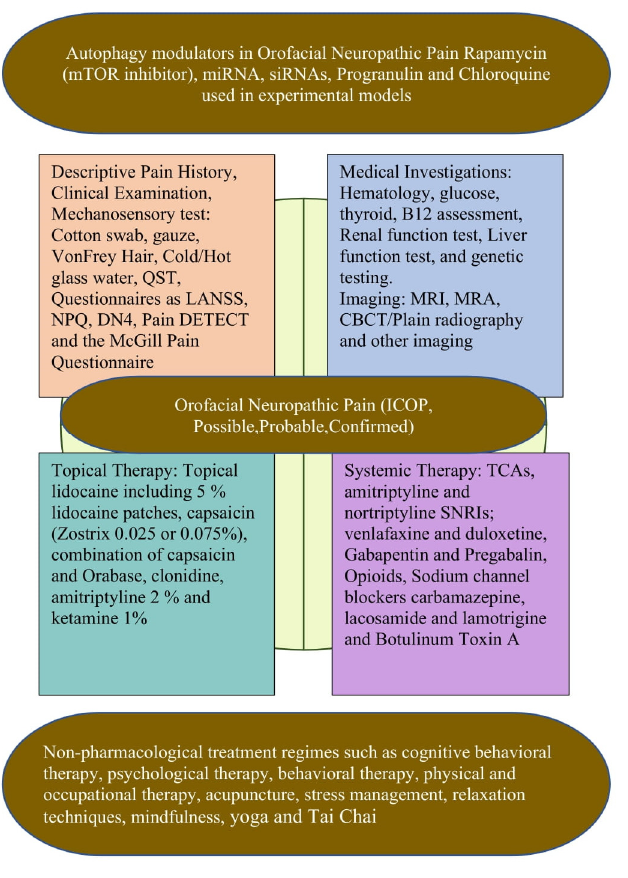
Figure 3. Summary of therapeutic potential of autophagy and clinical management of orofacial neu- ropathic pain.